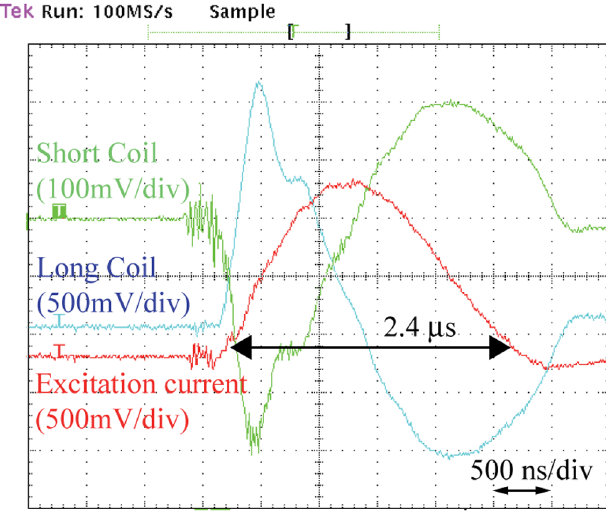
FIG. 14. (Color) Typical output waveforms of search coils mea- sured at a charging voltage of 16.7 kV. The red solid line represents an excitation current of the PSM. Green and cyan solid lines represent output signals of the short coil and the long coil, respectively. The search coils are placed at a horizontal location of 15 mm from the magnetic pole center of the PSM.